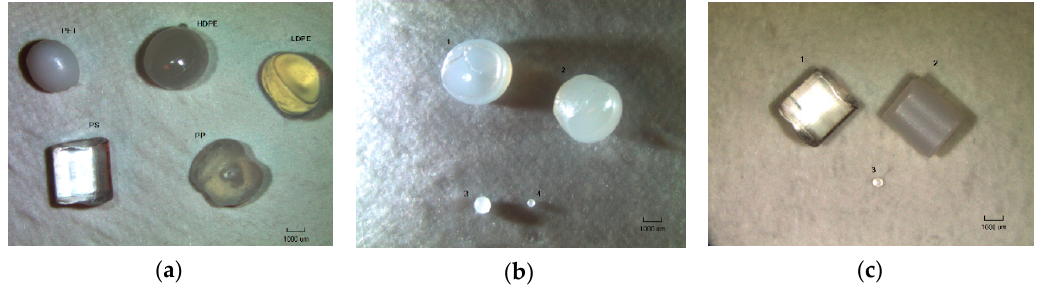
Figure 2. Plastic reference material used in the study: ( a ) PET, HDPE, LDPE, PS, PP; ( b ) HDPE in different sizes: 1, 2—3–4 mm, 3—0.9 mm, 4—0.45 mm; ( c ) PS in different sizes: 1, 2—3–4 mm, 3—0.5